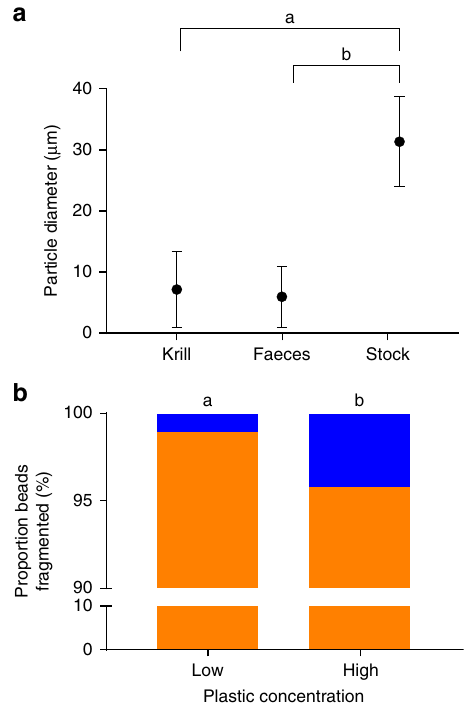
Fig. 1 Polyethylene particle size and proportion fragmented. a Microplastic particle size (mean ± S.D) in all sample types: whole krill homogenates, egested faecal pellets, and in the exposure stock suspension, letters denote statistically signi fi cant differences ( p < 0.05, two-sample Kolmogorov – Smirnov Test). b Proportion of whole beads (blue) and fragments (orange) isolated from Antarctic krill ( Euphausia superba ) exposed to a Low (20%) ( n = 9 krill with 16,308 particles detected) and High (80%) ( n = 9 with 51,168 particles detected) plastic concentrations. Letters denote statistically signi fi cant differences ( p < 0.05, Χ 2